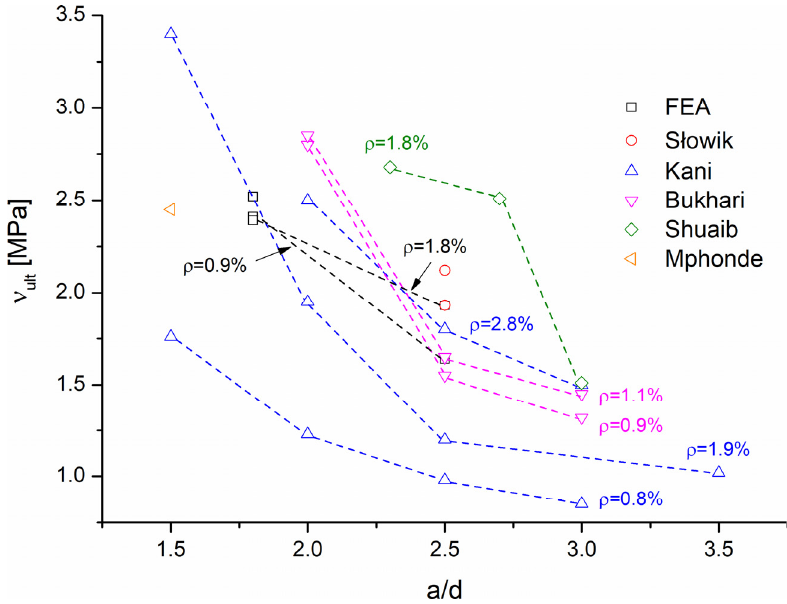
Figure 16. Ultimate shear stress from experiments and FE analyses for varying shear span-to-depth ratio a/d . ratio a/d